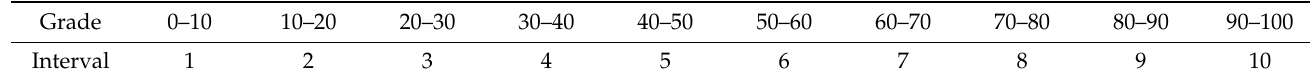
Table 4. Comparison table of privacy protection interval and grade.